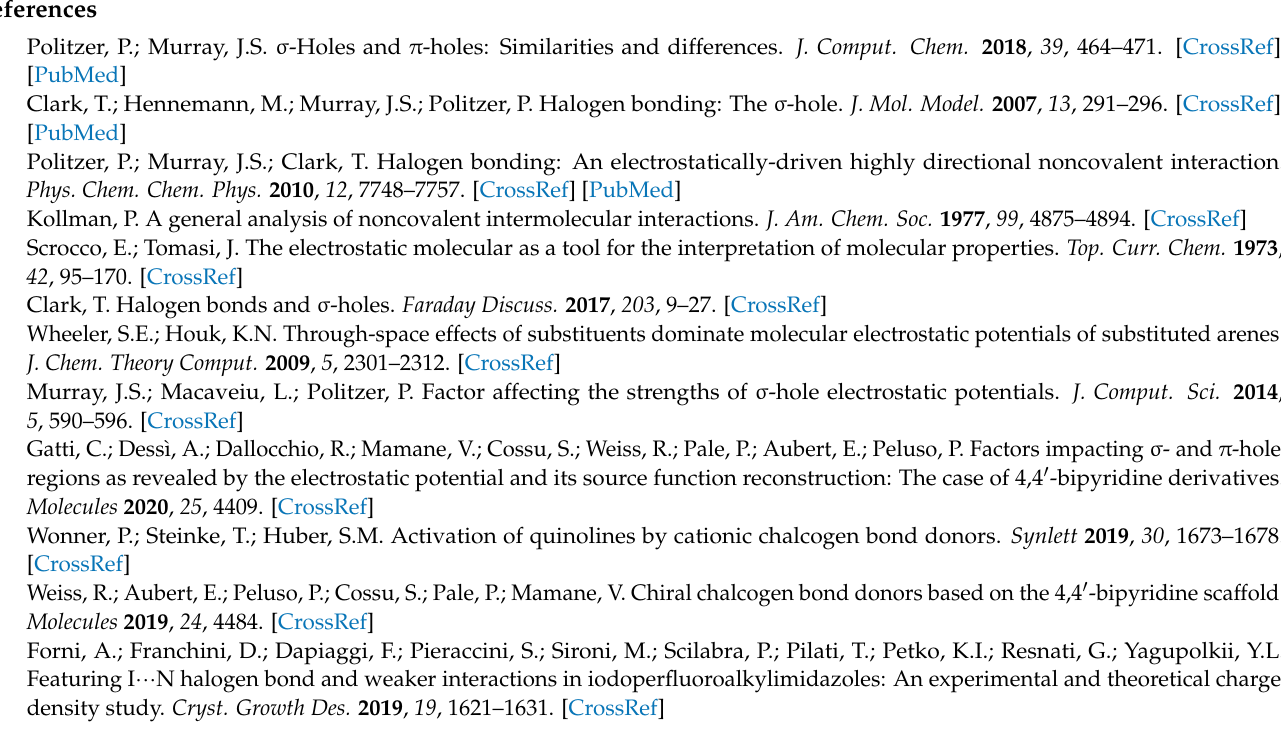
21–88 on cellulose- and amylose based CSPs, Figure S3: Linear regression analysis describing the relationships between ln α and ln k 2 for 2 – 8 on C-3,5diMe with mix B and mix C as MPs, Table S4: Temperature dependence of retention factors and van’t Hoff equations for 4,4 (cid:48) -bipyridines 2 – 8 on C-3,5diMe (Lux Cellulose-1), hex/IPA 90:10 (mix A), Table S5: Temperature dependence of retention factors and van’t Hoff equations for 4,4 (cid:48) -bipyridines 2 – 8 on C-3Cl,4Me (Lux Cellulose-2),